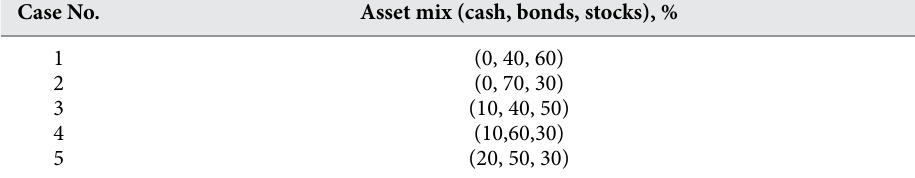
Table 4. The set of alternatives strategies Case